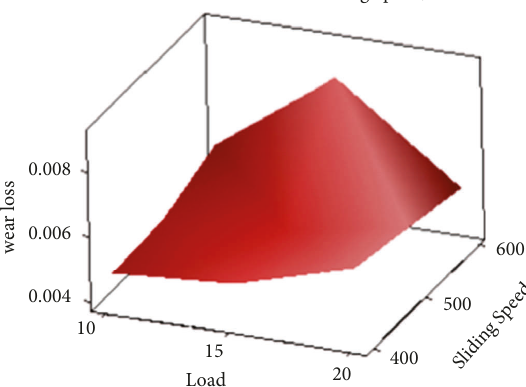
Figure 5: Surface plot graph for load % VS sliding speed to wear